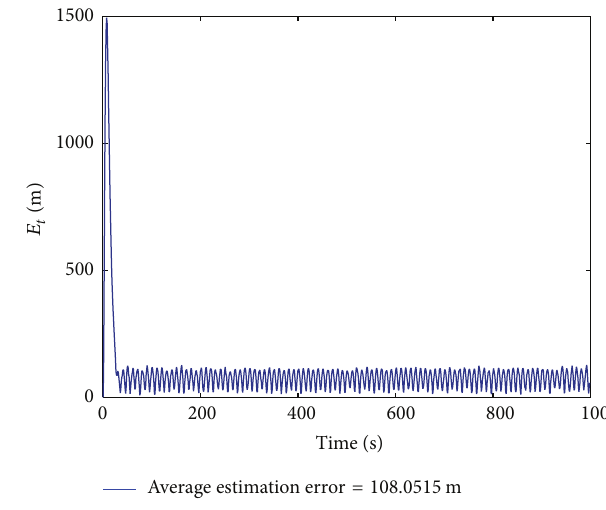
Figure 22: Estimation error of 𝛼 - 𝛽 - 𝛾 filter with 𝑔 𝑟,1 = 𝑔 𝑝,1 = 𝑔 2 = 0.75 .